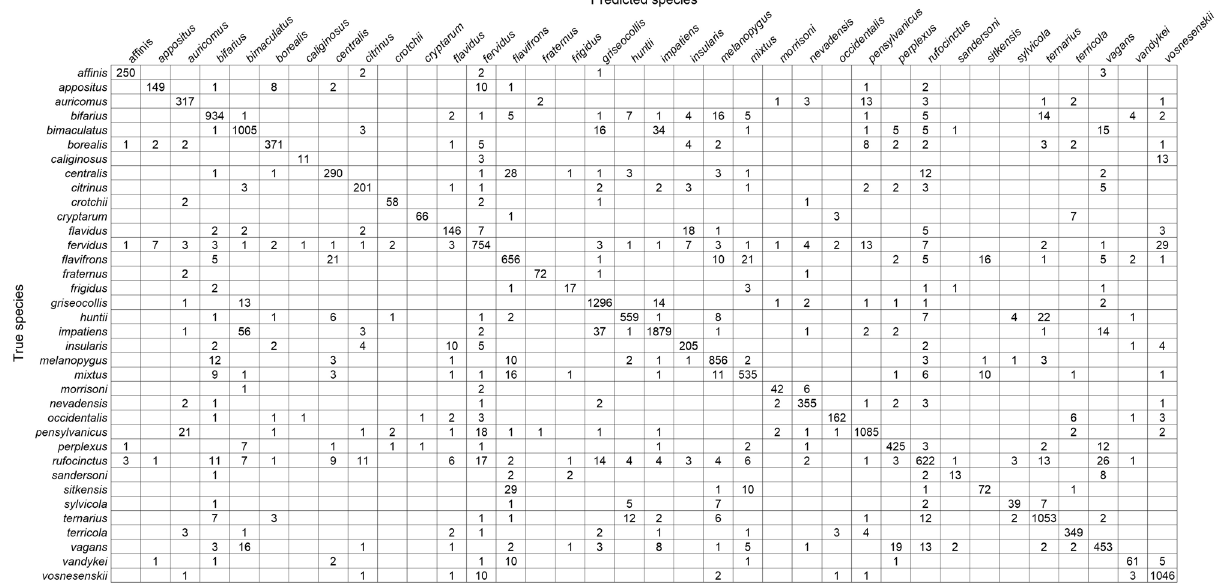
Table 2. InceptionV3 confusion matrix showing the number of test images for each